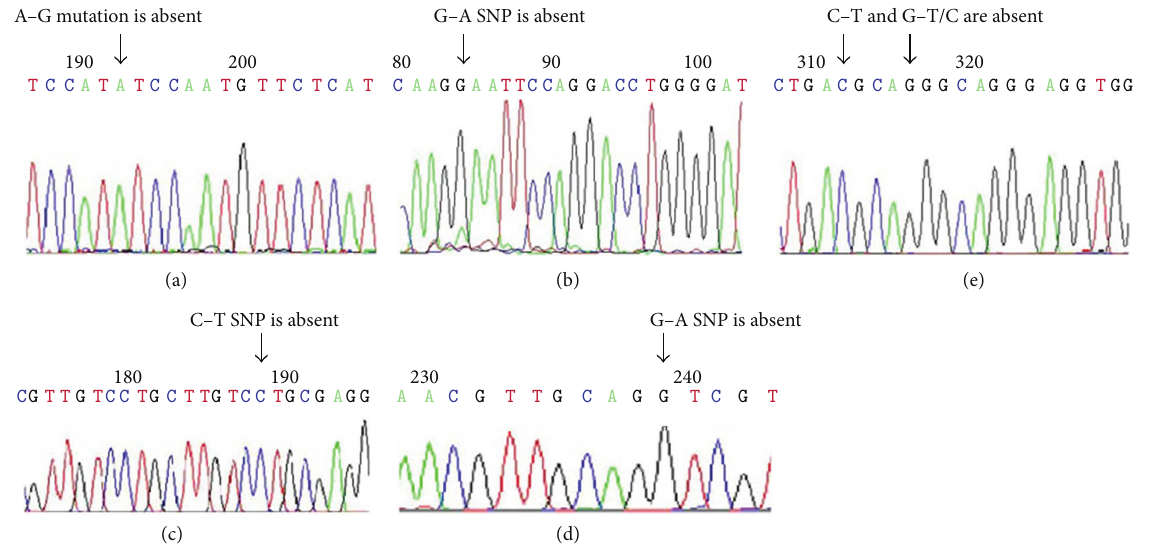
Figure 2: Sequencing chromatogram of miR-21 and miR-431 . (a) it shows the absence of A–G mutation downstream the pre-miR-21 . ((b), (c), (d), and (e)) they show the absence of rs12883709 G–A upstream the pre-miR-431 , rs76090066 C–T and rs12884005 G–A in the sequence of pre-miR-431 , rs61993318 C–T, and rs35695758 G–T/C downstream the pre-miR-431 .